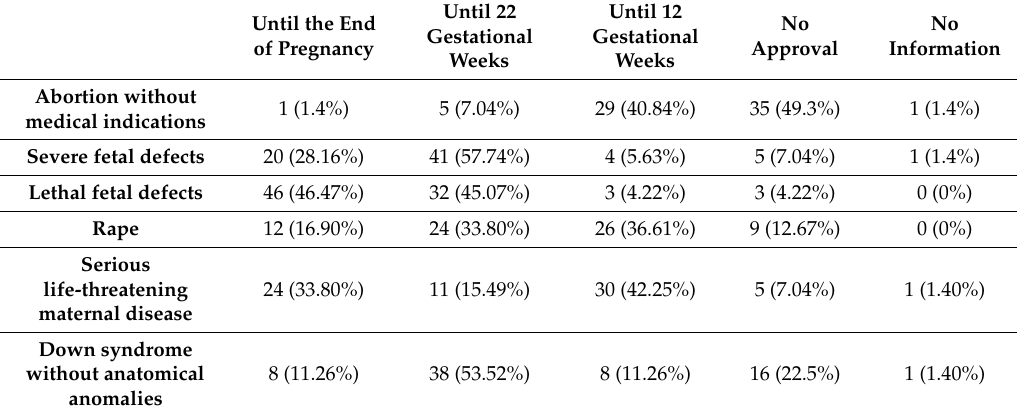
Table 2. Approval of pregnancy terminations in individual clinical